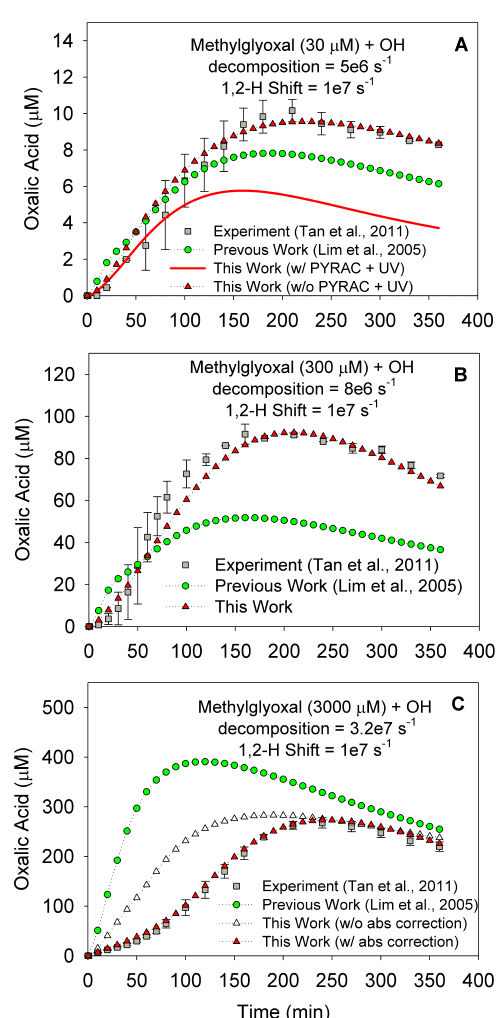
Fig. 8. Real-time profiles of oxalic acid produced from OH radical reactions of methylglyoxal at the initial methylglyoxal concentra- tions of 30 µM (A) and 300µM (B) and 3000µM (C) ; experimental results (Tan et al., 2012) and previous/current model simulations (using the model of Lim et al., 2005; this work). In (C) , simula- tions were performed with and without the absorption (abs) correc- tion by hypothetical light-absorbing organic products, with the same time profile as pyruvic acid, but a much higher extinction coefficient (1500cm − 1 M − 1 )